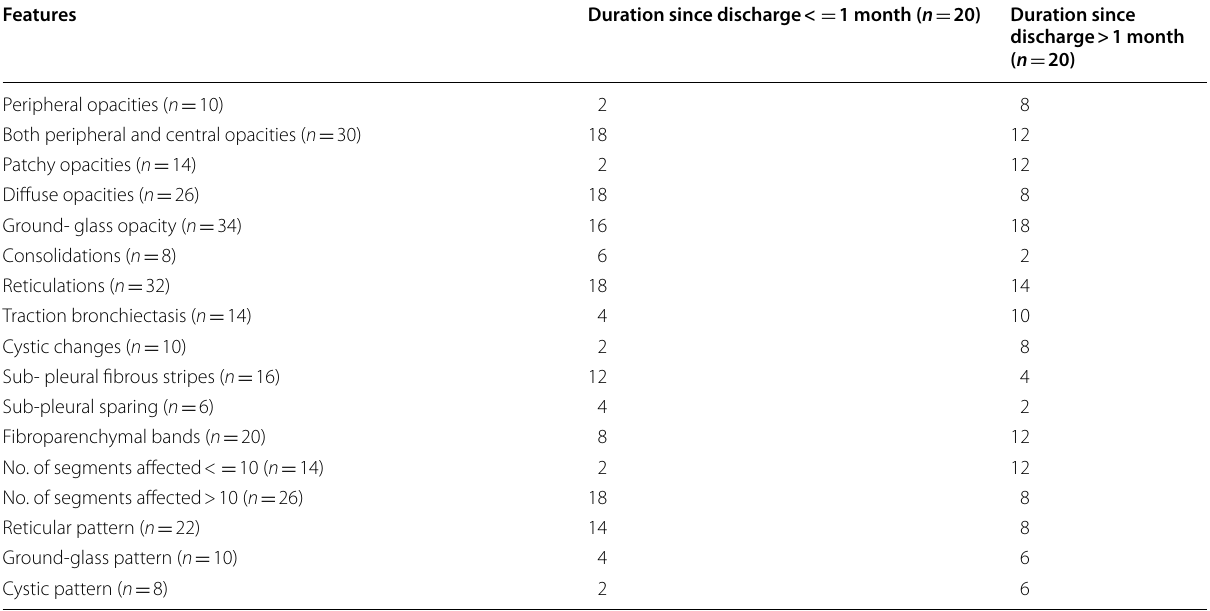
Table 3 Temporal association of HRCT findings with duration since discharge